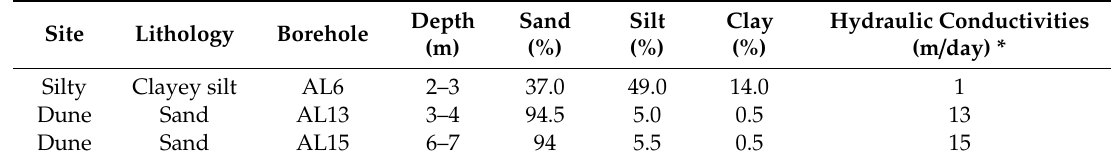
Table 1. Grain size and hydraulic conductivities in the two sites included in this